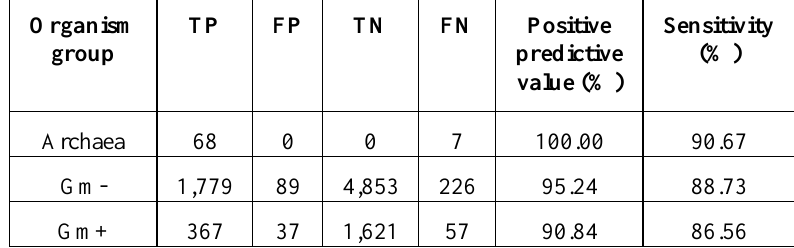
Table 4: Performance of the EPPP workflow. True positive (TP) and False negative (FN) denote the number of experimentally verified extracytoplasmic protein sequences that were predicted by the EPPP workflow as extracytoplasmic and intracytoplasmic, respectively. True negative (TN) and False positive (FP) represent the number of experimentally verified cytoplasmic proteins that were predicted by the EPPP workflow as intracytoplasmic and extracytoplasmic, respectively.